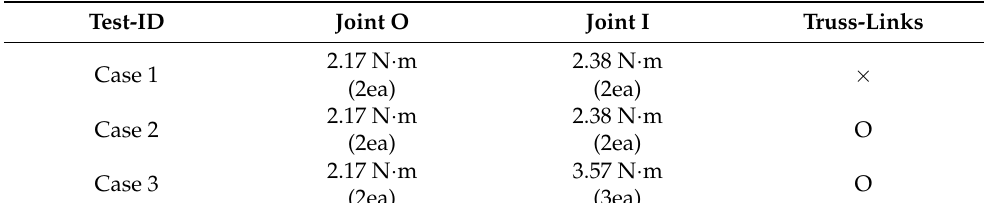
Figure 8. Configuration of red markers on dummy panels.